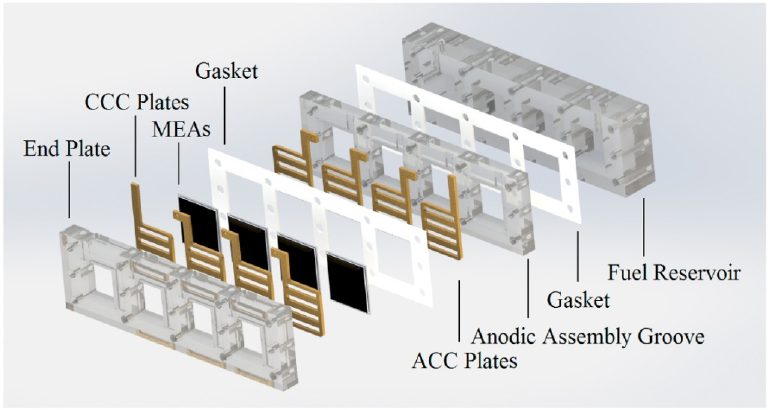
Figure 12. Schematic of the assembled PS-DMFC stack to verify the model based on Debye–Hückel ionic atmosphere theory in exploded view. Reproduced from [144] with permission from Else- vier